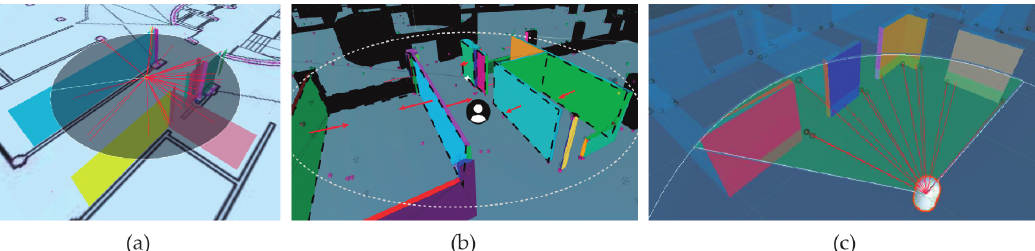
Figure 8. The selection of surrounding walls to the user position in the virtual world: ( a ) Plane selection in the search area, ( b ) Normal calculation of virtual planes and ( c ) computing of plane visibility from the user